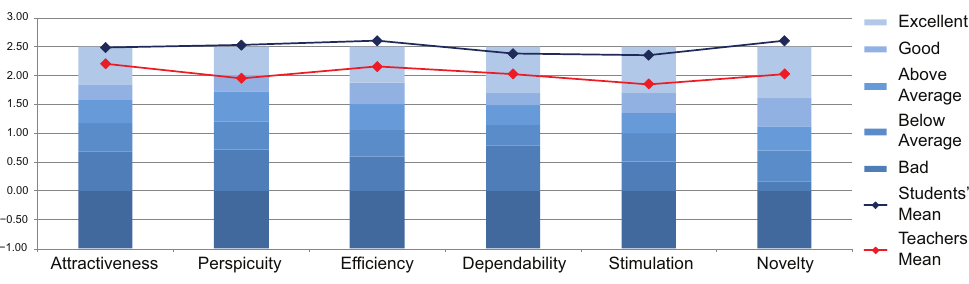
Figure 9. Benchmark